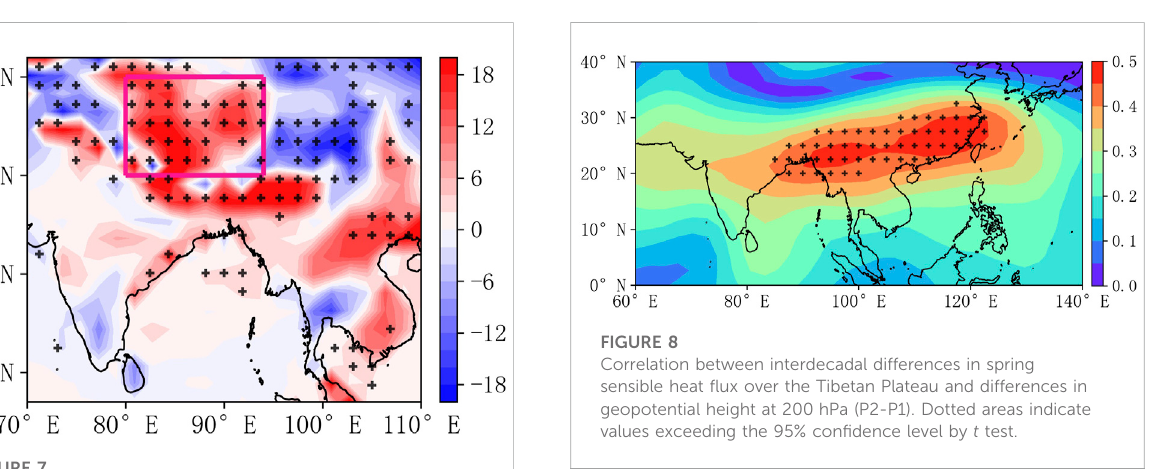
FIGURE 7 Interdecadal differences in spring sensible heat fl ux over the Tibetan Plateau (P2-P1). The red box indicates the Tibetan Plateau region. Dotted areas indicate values exceeding the 95% con fi dence level by t test.